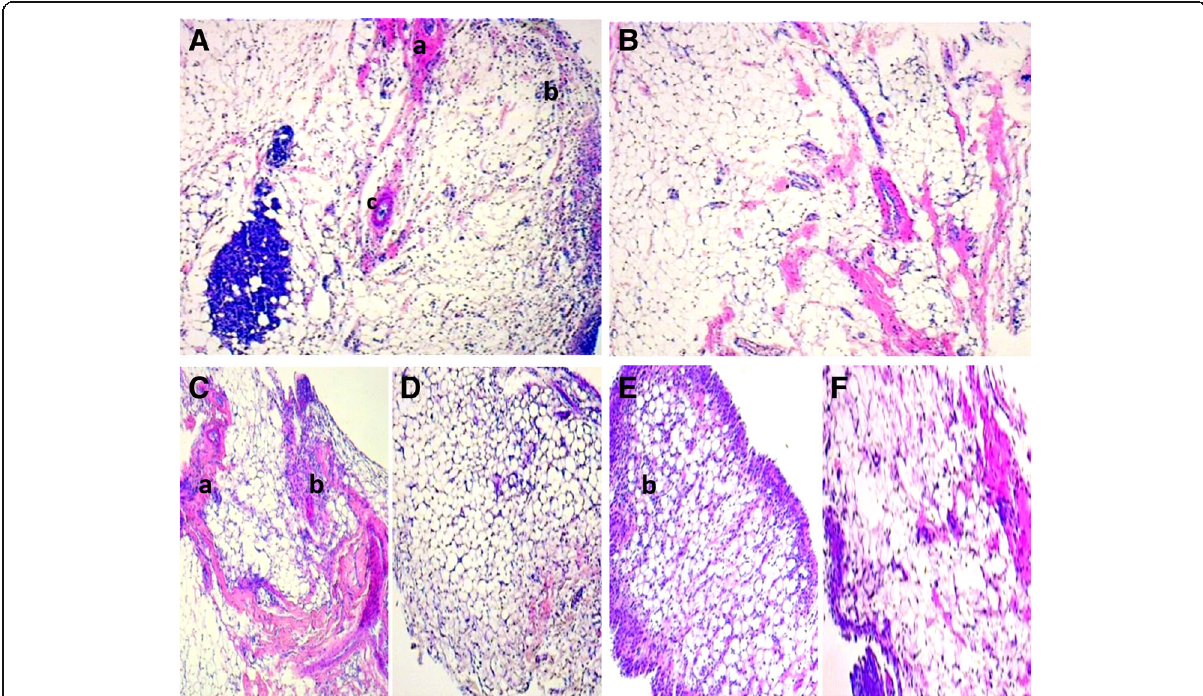
Fig. 7 Microphotograph of H&E-stained histological section of the synovial membrane of rats (40x magnification). a zymosan control: intense leukocyte infiltrate with fibrosis area. b normal control: structures preserved and within normality. c LfAE 100 mg/kg with presence of leukocyte infiltrate and areas of fibrosis. d LfAE 200 mg/kg presenting reduction of inflammatory parameters in the synovial membrane. e LfAE 300 mg/kg group presenting mild leukocyte infiltrate in the synovium. f Standard 100 mg/kg with mild leukocyte infiltrate. a - fibrosis; b - inflammatory infiltrate; c –